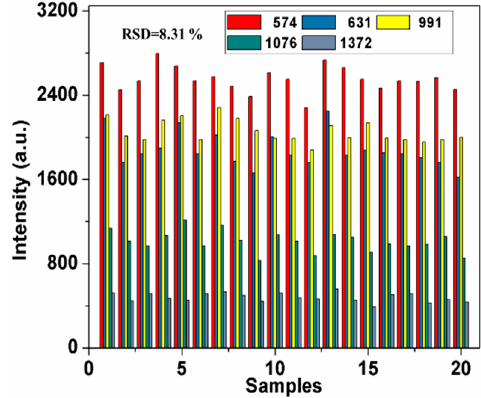
Figure 4. Intensity variation of peaks at 574, 631, 991, 1076 and 1372 cm − 1 from twenty samples containing 2.5 mg/L pirimiphos-methyl.